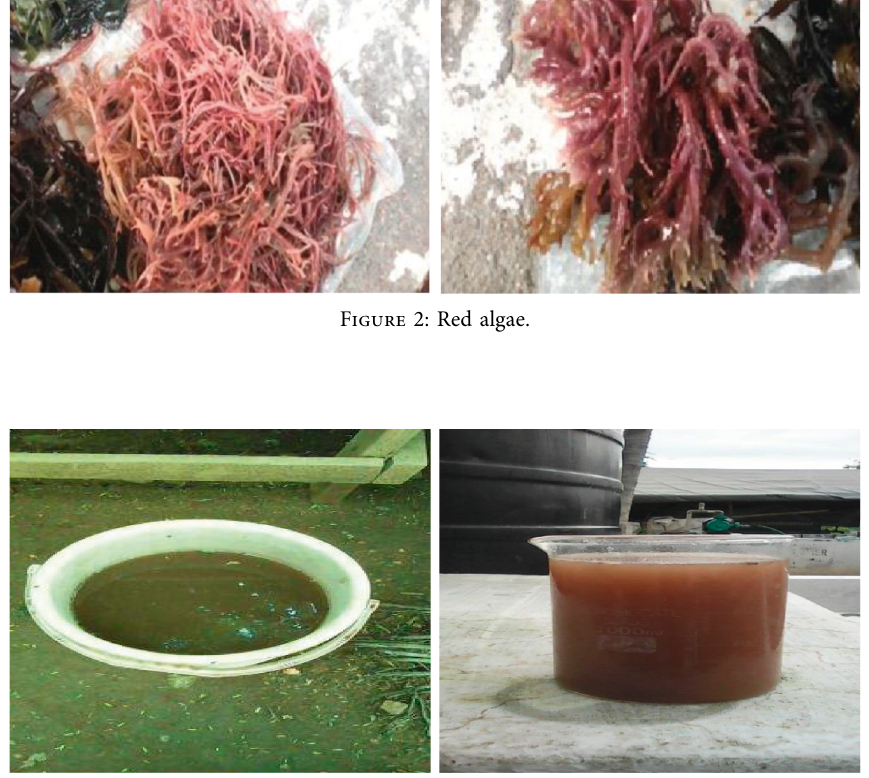
Figure 3: Collection of the soak effluent from E.K.M. Leather Processing Company.